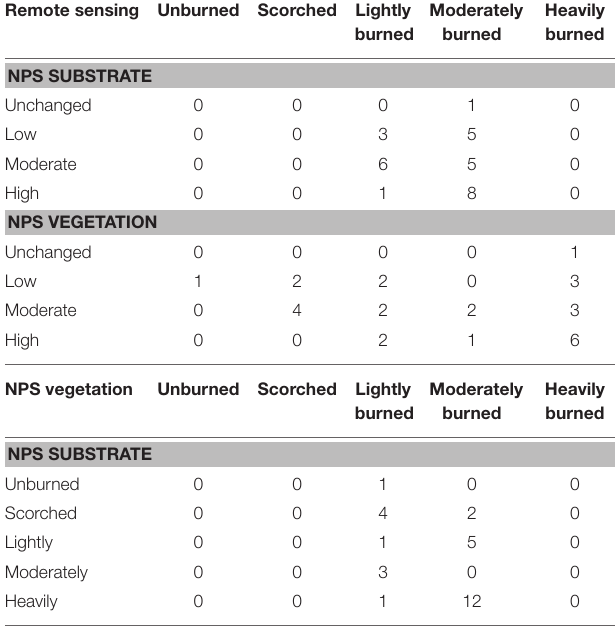
TABLE 2 | Severity classification matrix showing distribution of plots (count) assessed for fire severity level using remote sensing (RS), and National Park Service (NPS) vegetation and substrate severity metrics assessed in the field